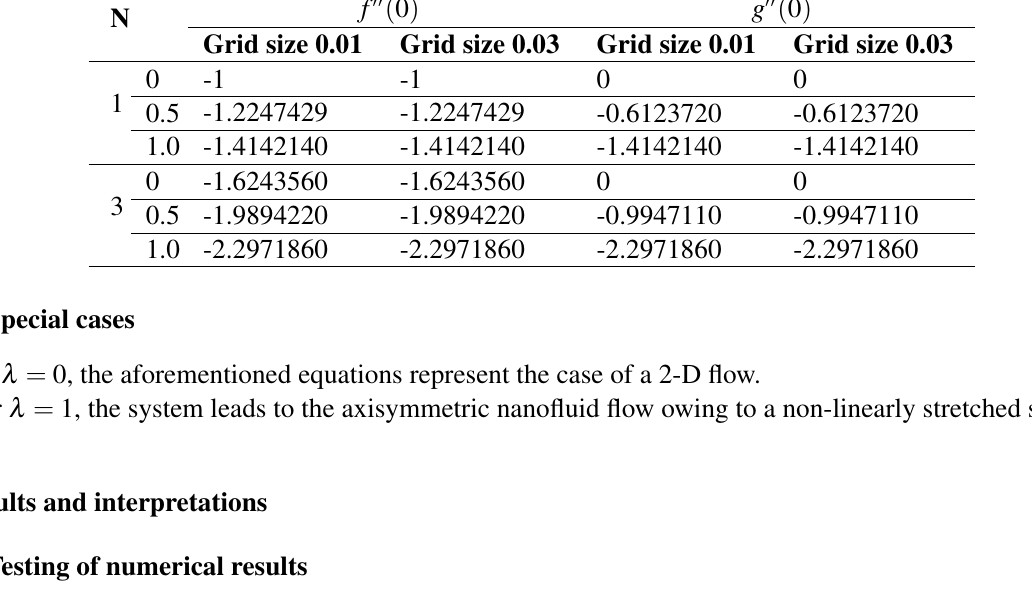
Table 2 Comparisons of the values of f (cid:48)(cid:48) ( 0 ) and g (cid:48)(cid:48) ( 0 ) in the absence of the magnetic field for different grid sizes f (cid:48)(cid:48) ( 0 N